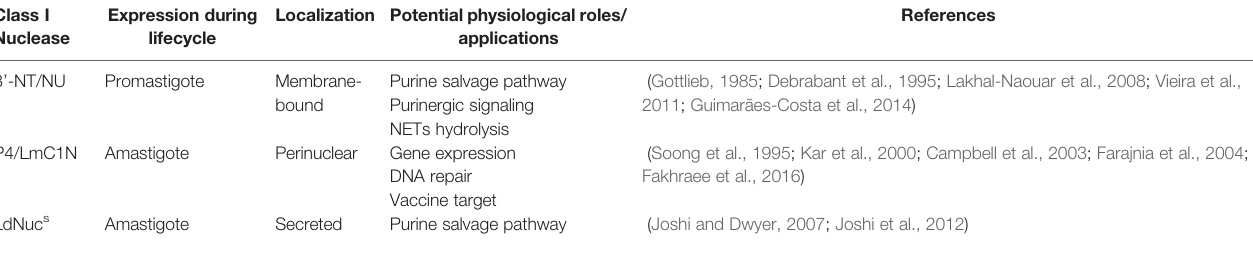
TABLE 1 | Class I nucleases of Leishmania